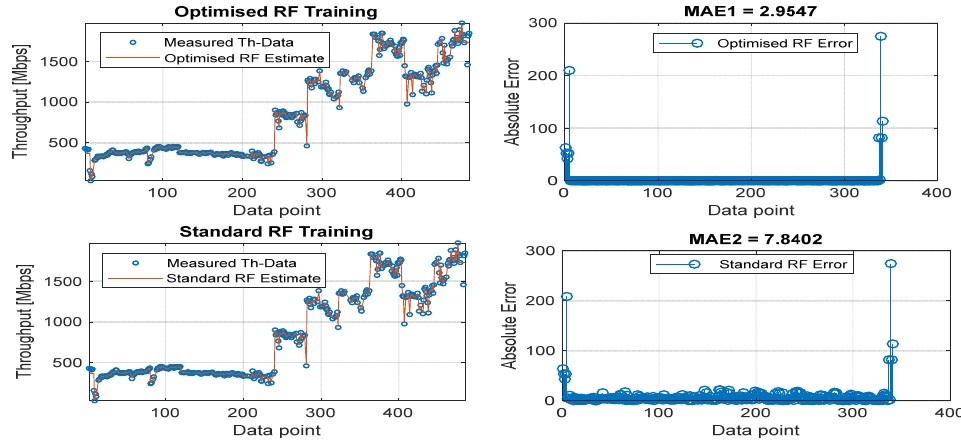
Figure 11. Predicted throughput quality performance of the proposed RF-LS-BPT model and standard RF model at 100 m distance.